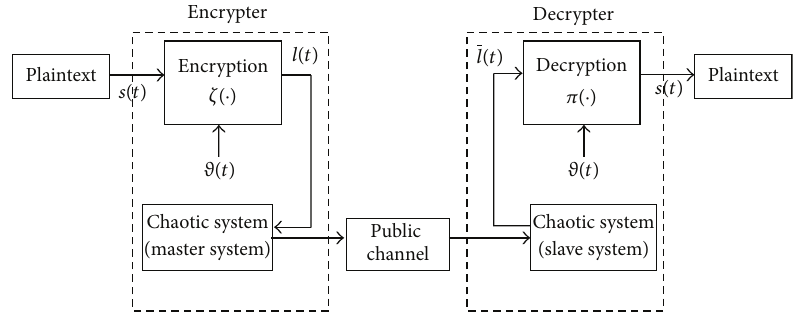
Figure 1: Block diagram of the chaotic synchronization cryptosystem.